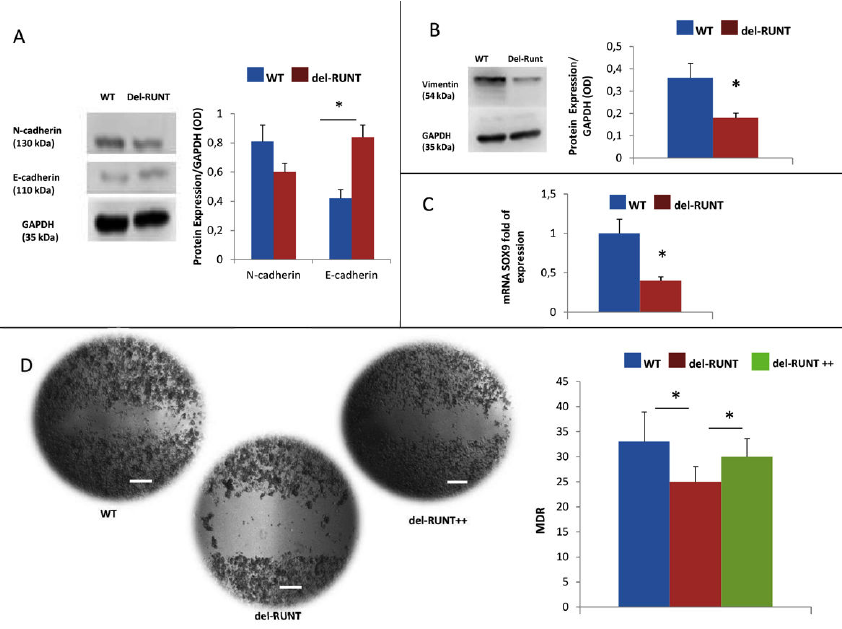
Figure 8. Western blot analysis comparing N and E cadherin expression in WT (A375) and del-RUNT cells. GAPDH, internal control. The deletion of the RUNT domain in RUNX2 affected the EMT, as shown by the higher expression of E cadherin and the lower expression of N cadherin normalized to GAPDH and expressed as OD (Optical density) ( A ). The 38 aa deletion is highlighted in red. Vimentin expression was also reduced in del-RUNT cells as shown in western blot analysis and normalized to GAPDH control ( B ). mRNA expression analysis, evaluated by Real Time PCR and normalized to the housekeeping genes B2M and GAPDH , showed the downregulation of SOX9 , a gene involved in the EMT process, as well ( C ). Migration ability (expressed as relative migration distance (RMD)) was also reduced in del-RUNT cells ( D ). The re-expression of RUNX2 in del-RUNT cells (del-RUNT ++) restored cell migration capability. * p < 0.05; scale bar 100 µ